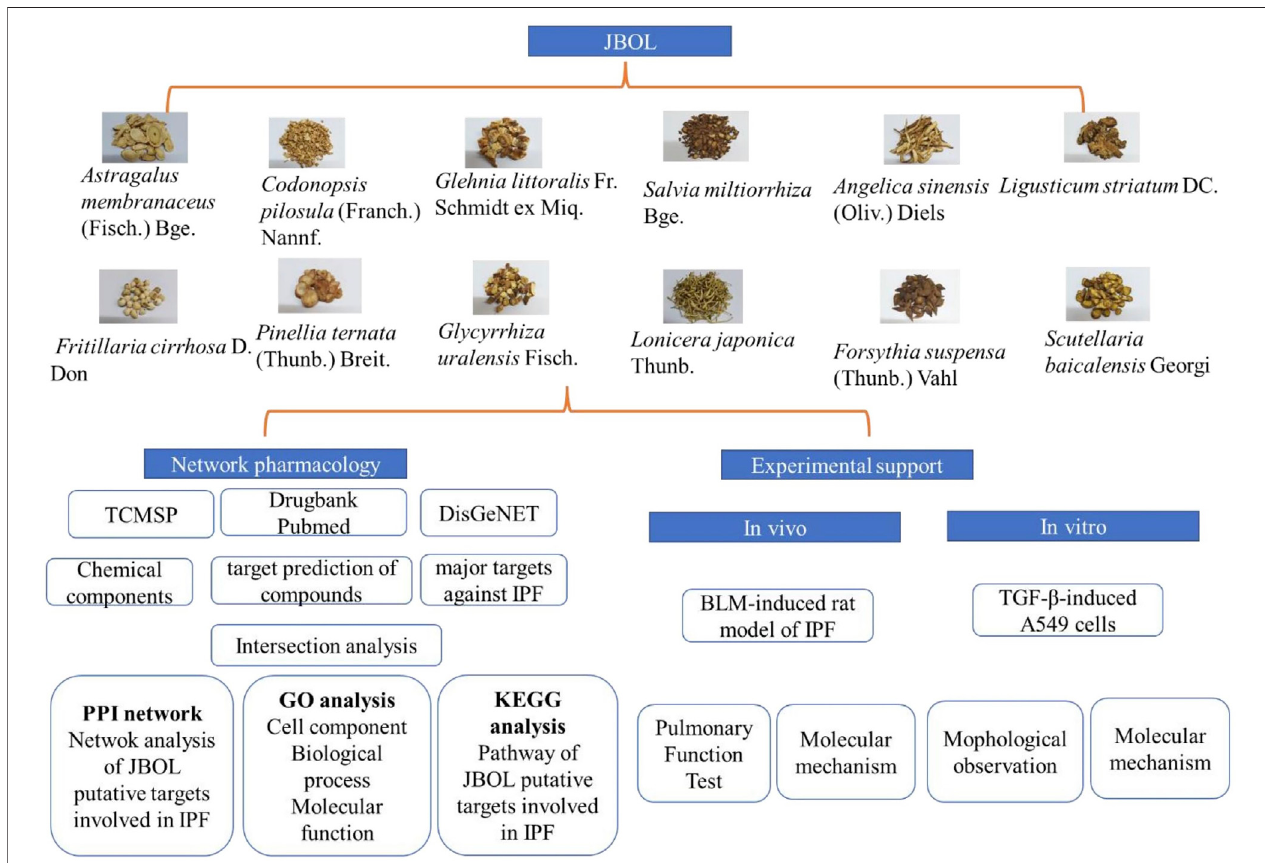
FIGURE1| Theresearchwork fl ow.CompoundsfromJBOLwereidenti fi edbasedontheTCMSPdatabaseconsideringtheirdrug-likelinessandoralbioavailability. Thetargetsalsowerecollected.Then,theIPF-relatedtargetswerescreenedusingtheDisGeNETdatabase.TheoverlappingJBOLtargetsandIPFtargetswereusedto constructthePPInetworkwiththeSTRING database.Metascapewasusedtoanalyze theGOresults andtheKEGGpathway enrichment.Theherb – compound – target network was constructed using Cytoscape. Experimental validation of the rat and cell culture models was performed to con fi rm the mechanism of action of JBOL.